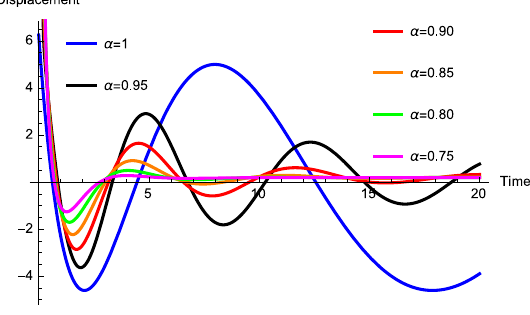
Figure 11. Numerical simulation for Equation (51) considering different values of α , arbitrarily chosen.